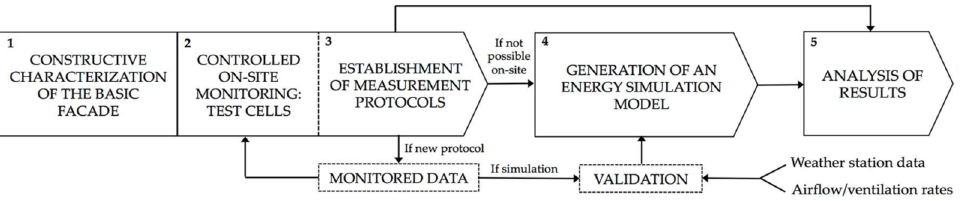
Figure 2. Methodological scheme.